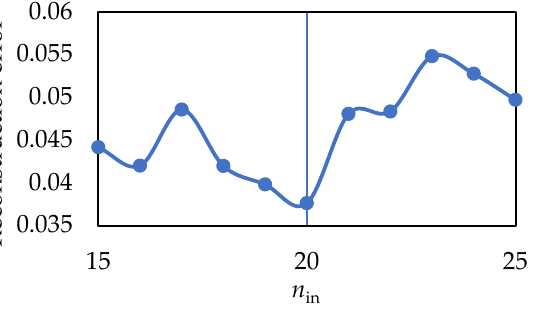
Figure 12. Relationship between the number of nodes in the h 1 layer and reconstruction error. Table 9. Table of the nodes number in the h 1 layer and reconstruction error